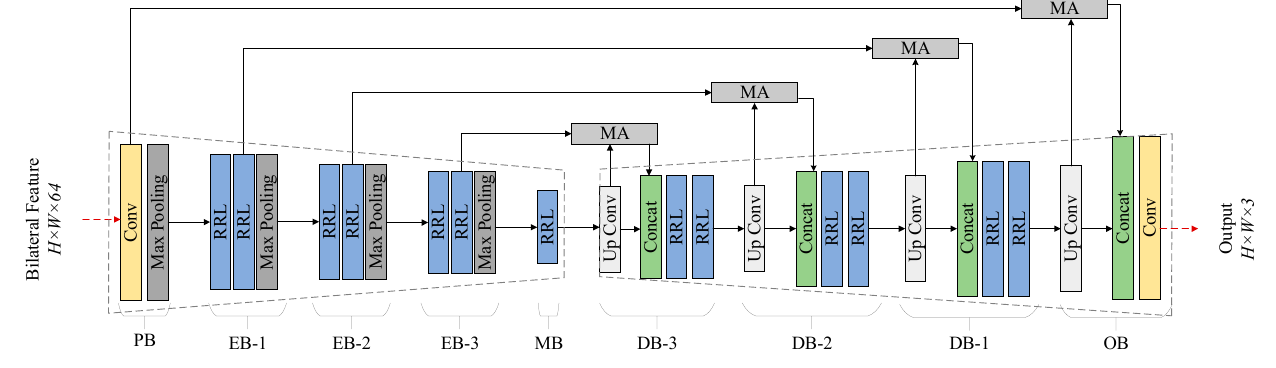
Figure 3. Structure of proposed feature fusion module.